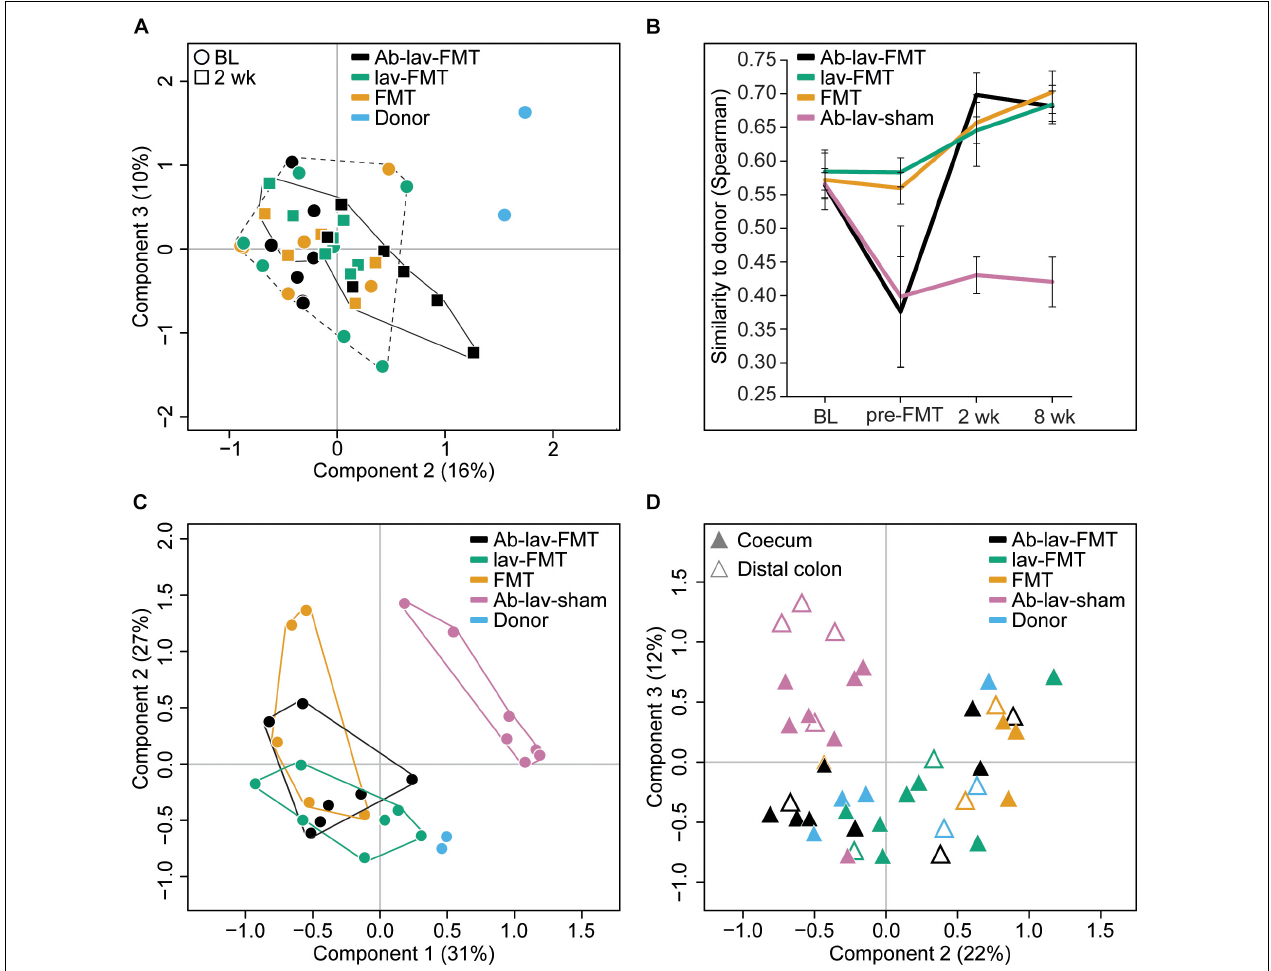
FIGURE 4 | (A) PCoA of fecal microbiota composition: effects of antibiotic pre-treatment and study time point. Ab-lav-sham group is excluded to visualize the distribution of the FMT group samples in more detail. (B) Microbial similarity to donor for different groups throughout the study. Similarity measured with Spearman correlation. (C) PCoA of fecal microbiota composition at 8 weeks after (sham) FMT: significant separation of Ab-lav-sham group from the other groups ( p = 0.001, PERMANOVA). (D) PCoA of mucosal microbiota composition at 8 weeks after (sham) FMT: significant effects of antibiotic treatment ( p = 0.001, PERMANOVA) and biopsy location ( p = 0.001,